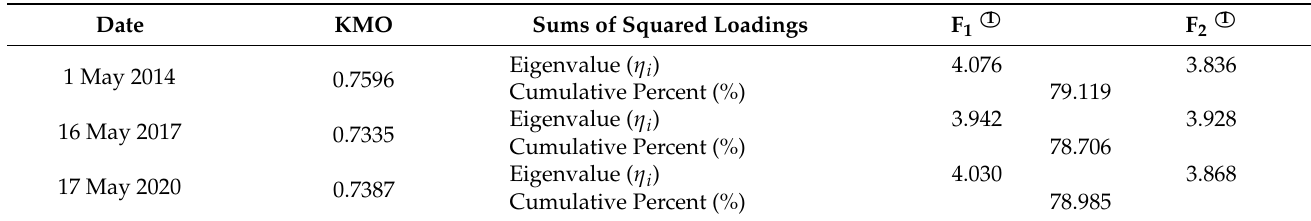
Table 6. Total variance explained by principal component